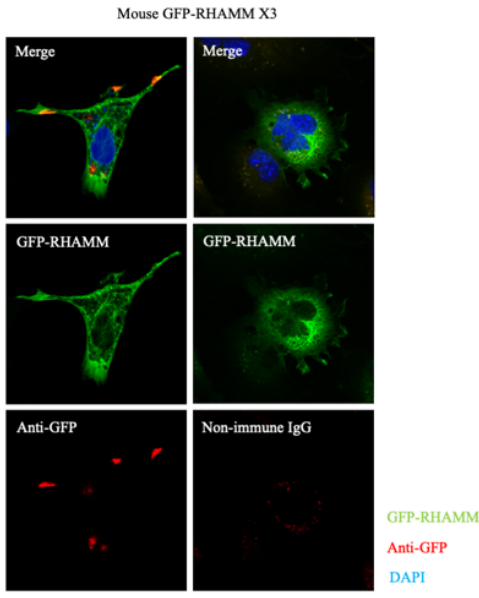
Figure 6. Subcellular localization of GFP-RHAMM expressed in mouse fibroblasts. Non- permeabilized cells exhibit diffuse localization for GFP-RHAMM X3. Anti-GFP antibodies were used to detect cell-surface RHAMM, which occurs in cell processes.